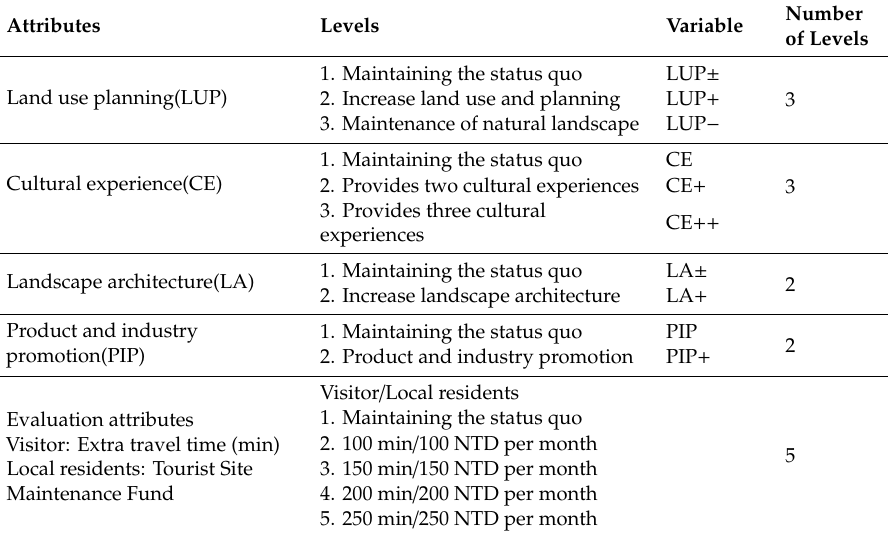
Table 1. Attributes and attribute levels of fishing village tourist